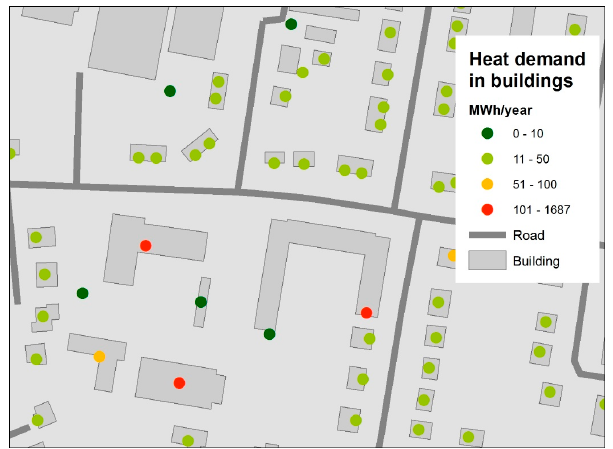
Figure 2. Heat atlas example showing annual heat demand in buildings.